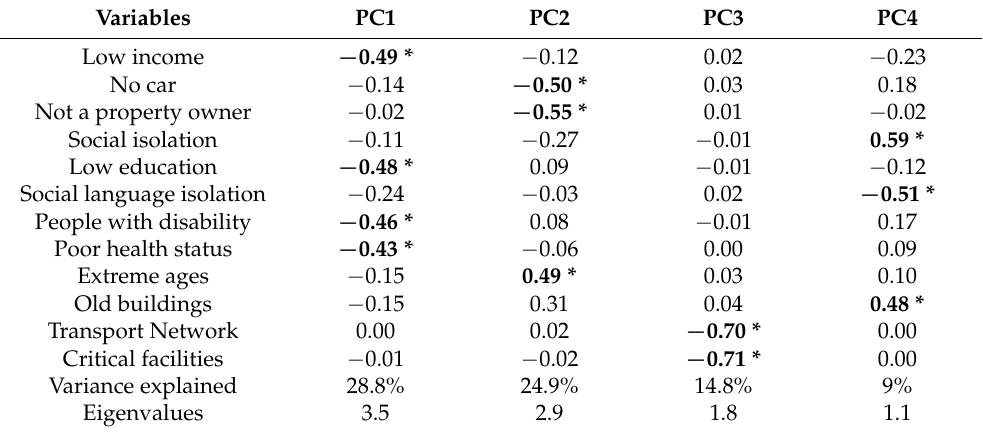
Table 4. Factor loadings and variance explained from Principal Component Analysis (PCA) for the vulnerability assessment. Significant factor loadings for each PC are over |0.4| and with an asterisk. Variables PC1 PC2 PC3 PC4 Low income − 0.49 * − 0.12 0.02 − 0.23 No car − 0.14 − 0.50 * 0.18 Not a property owner − 0.02 − 0.55 *